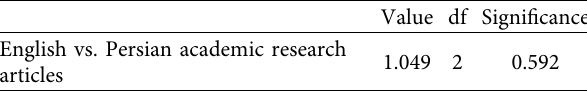
Table 2: Chi-square test for attitude resources across English and Persian academic research articles.